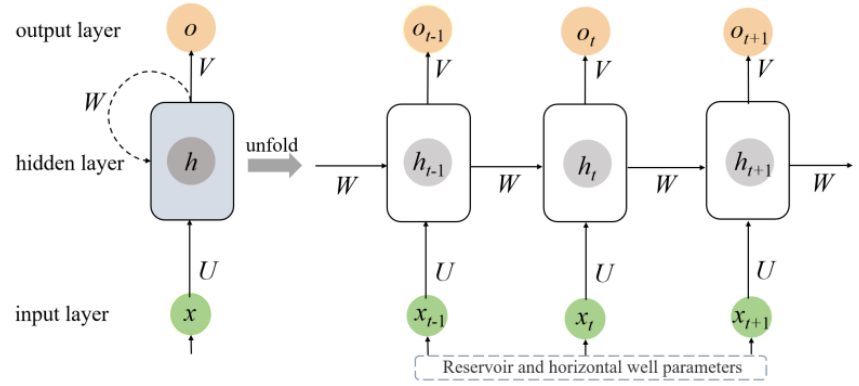
Figure 3. Structure of RNN hidden layer deployment.